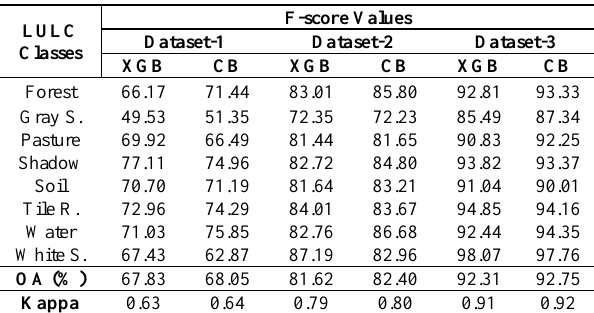
Table 4. Accuracy results of maps produced by